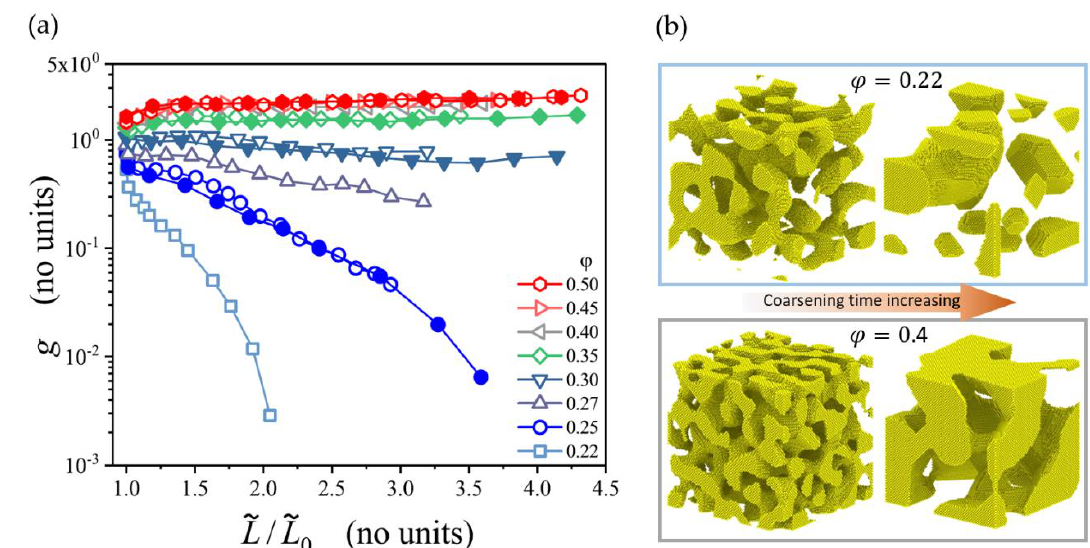
Figure 8. ( a ) Scaled genus plotted over the characteristic length of nanoporous structures calculated by kinetic Monte Carlo (KMC) simulations. Self-similar coarsening for the solid fraction ϕ > 0.3 is observed [47]. ( b ) Structure with ϕ = 0.22 losing connectivity by breaking up into clusters, whereas the structure of ϕ = 0.4 coarsens self-similar with increasing time [47]. Reprinted from [47] and available under the terms of the Creative Commons Attribution 4.0 International license (CC BY 4.0).